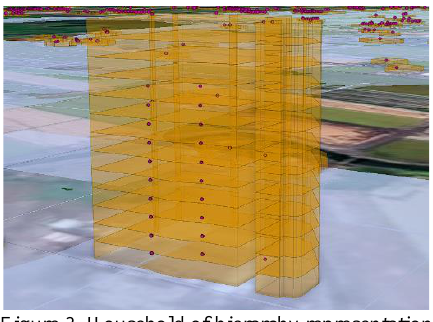
Figure 3. Household of hierarchy representation